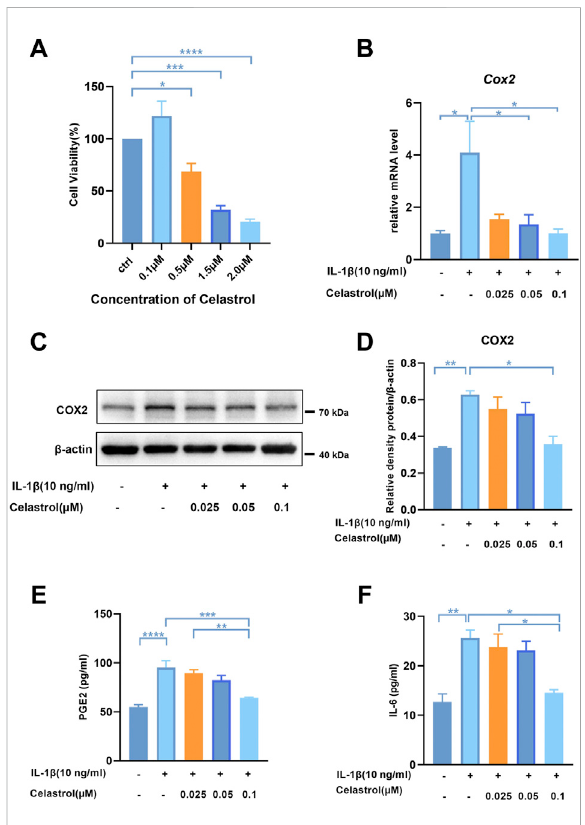
FIGURE 3 CelastrolinhibitedIL-1 β -inducedin fl ammatorymediatorsinrat chondrocytes. (A) Rat chondrocytes viability for 24 h treated with celastrol at different concentrations examined by CCK-8 kit. (B) The mRNAlevelsofCOX2inratchondrocyteswereassayedbyreal- time PCR. (C) Representative Western blot results for COX2 in rat chondrocytestreatedasindicated. (D) Quanti fi cationofWesternblot datafrom (C) . (E,F) LevelsofPGE2andIL-6wereassayedbyELISA.All data represent mean ± S.E.M.* p < 0.05, ** p < 0.01, *** p < 0.001 and **** p < 0.0001. All experiments were repeated 3